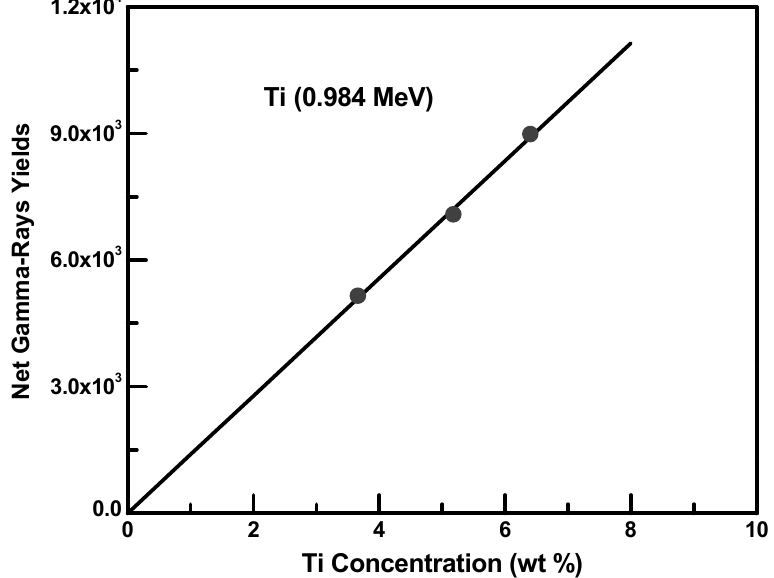
Figure 7. The yields of titanium prompt gamma-ray at 0.984 MeV as a function of its concentration in soil samples. The solid line represents the best fit for the data using the inverse variance weighting scheme.